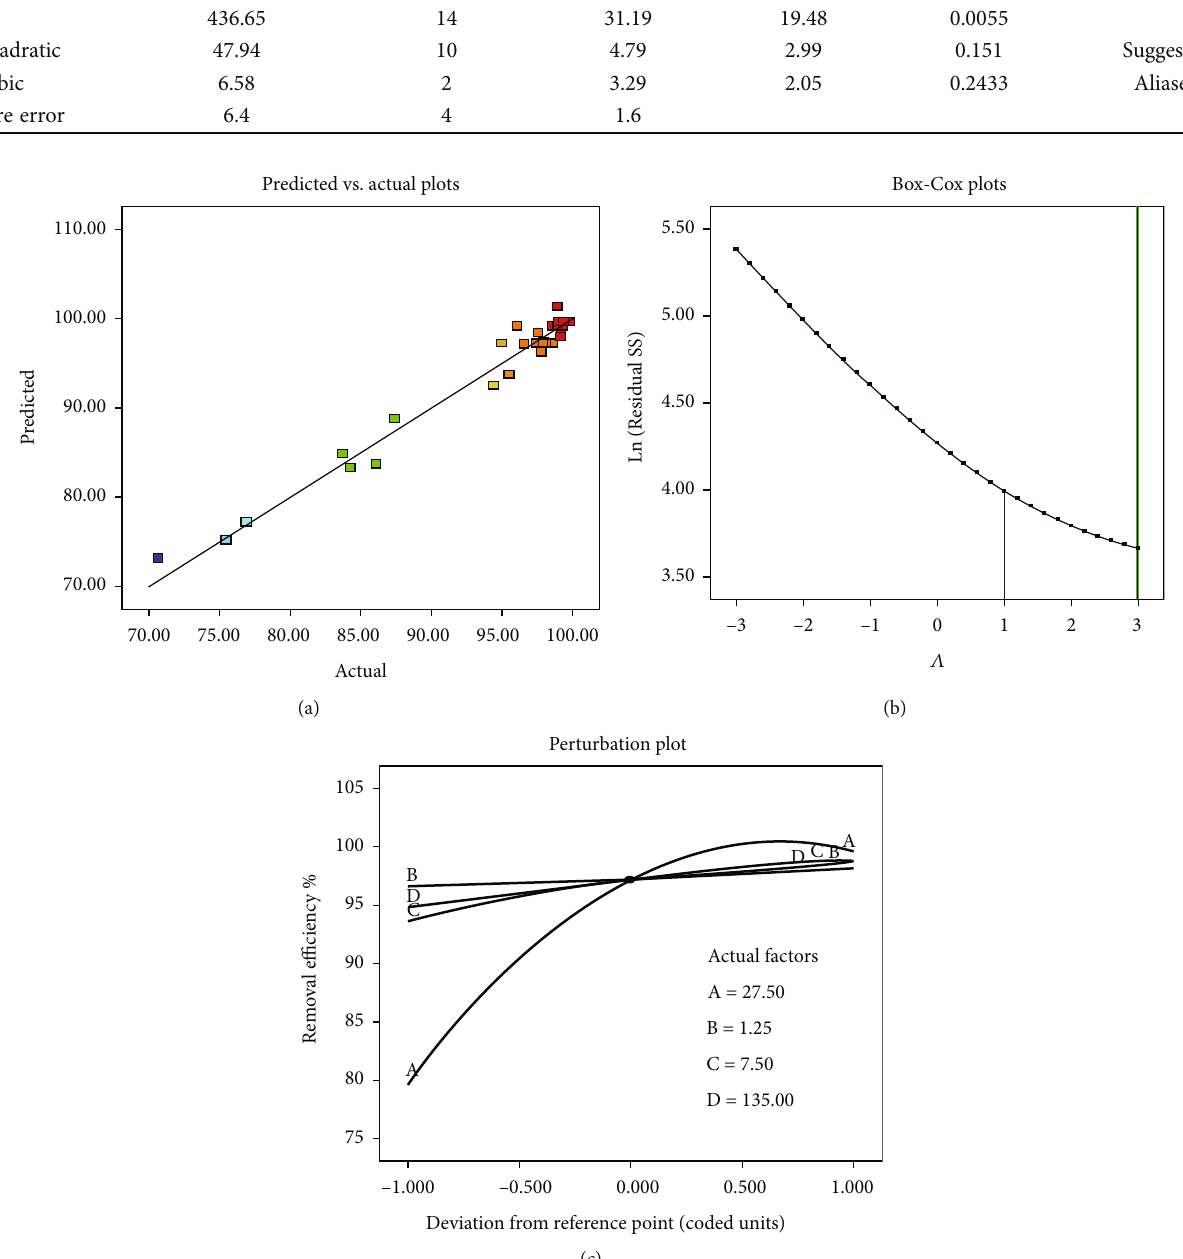
Figure 2: (a) Predicted vs. actual plots; (b) Box-Cox plots; (c) perturbation plot for adsorption of Congo red dye on breadfruit leaf biochar